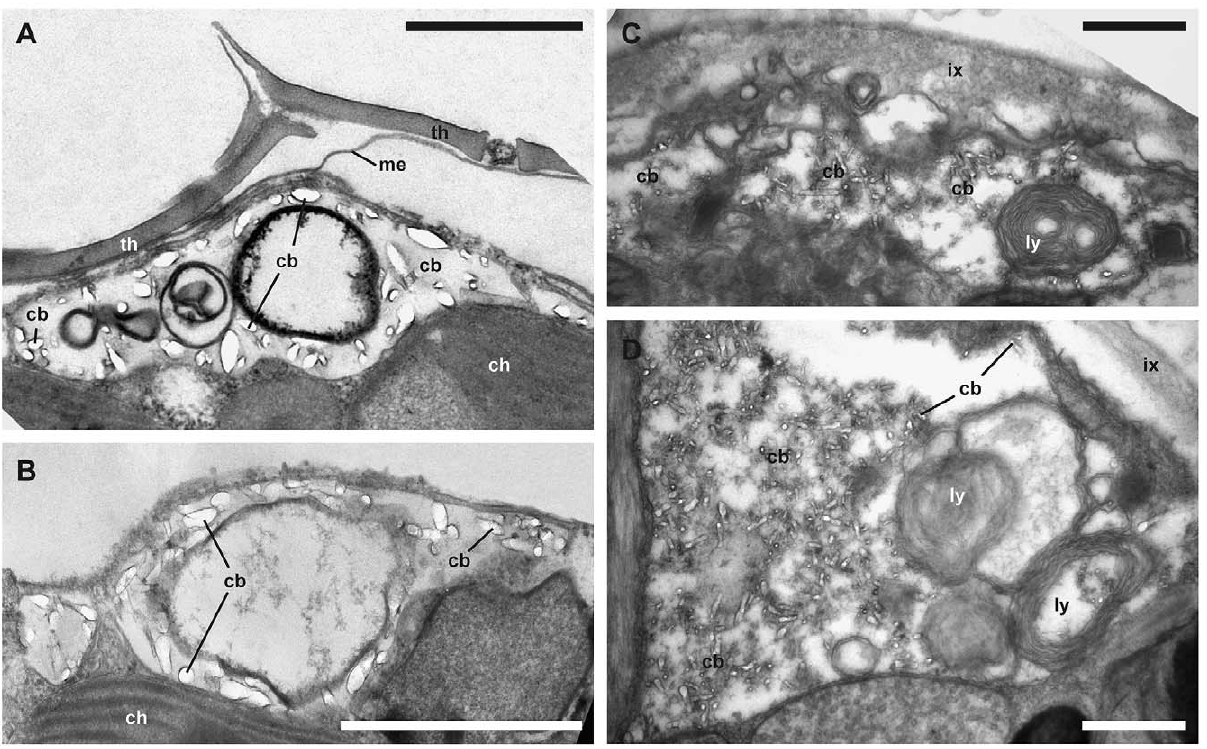
Figure 6. Vacuolar crystal-like particles. (TEM). A: Scrippsiella trochoidea (GeoB*185, early coccoid cell, the theca is still attached; note the intravacuolar vesicles). B. Scrippsiella trochoidea (GeoB*185). C. Scrippsiella aff. trochoidea (GeoB 283, note the lysozymes as intravacuolar membrane whorls). D. Scrippsiella aff. trochoidea (GeoB 283, note the lysozymes as intravacuolar membrane whorls). Abbreviations: cb, crystal-like particle; ch, chloroplast; ix, inner matrix; ly, lysosme; me, unit membrane; th, thecal plate. Scale bars: 1 m